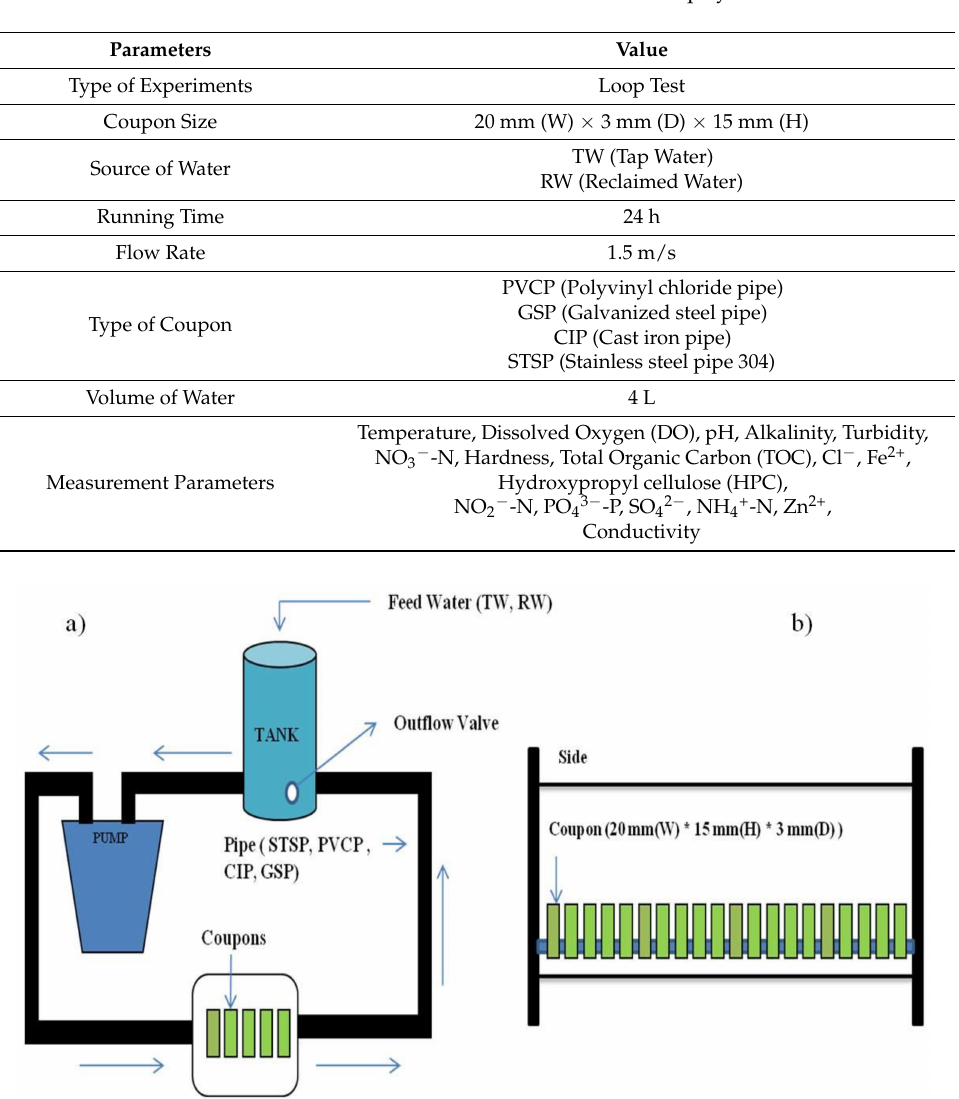
Figure 1. ( a ) Schematic of the simulated distribution loop system and coupon tester used in the experiment; ( b ) Coupons installed in the